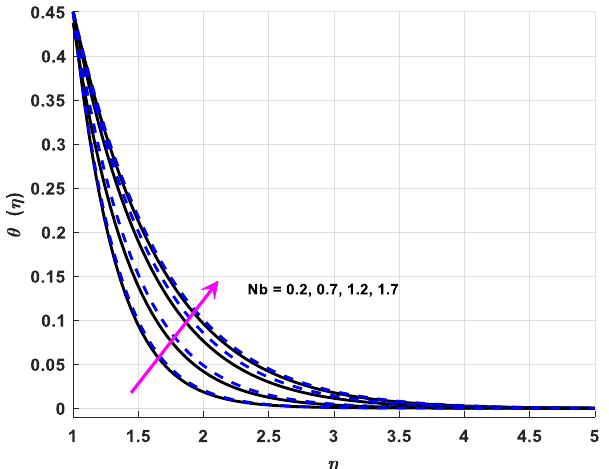
Figure 8. Variations in temperature profiles owing to changes in Nb .